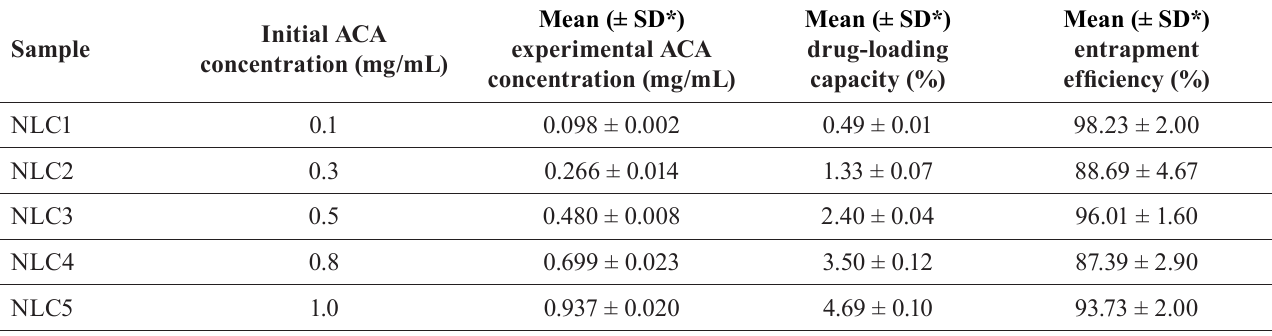
TABLE VI – Drug-loading capacity and entrapment efficiency of ACA-NLCs